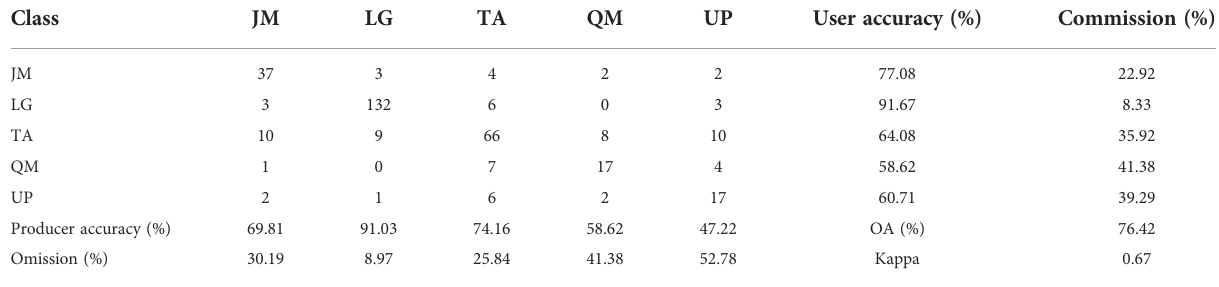
TABLE 4 Optimal results of tree species identi fi cation and accuracy indices based on LiDAR